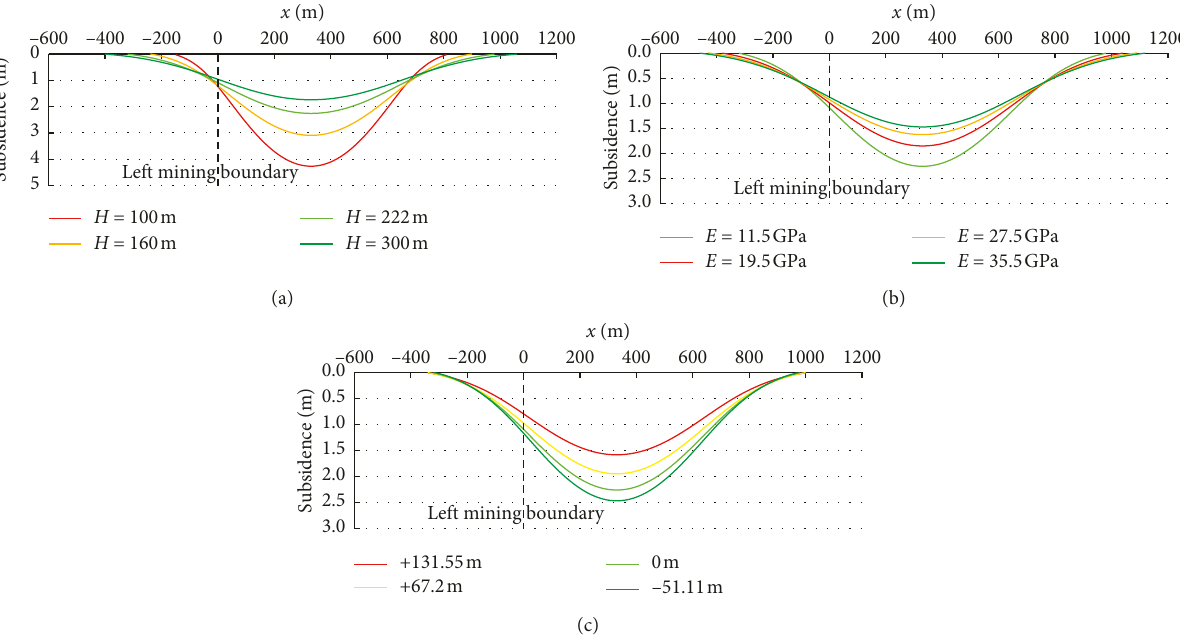
Figure 10: Subsidence curves of main section I with different overburden strata compositions. (a) Different UTHS thicknesses. (b) Different UTHS strengths. (c) Different UTHS